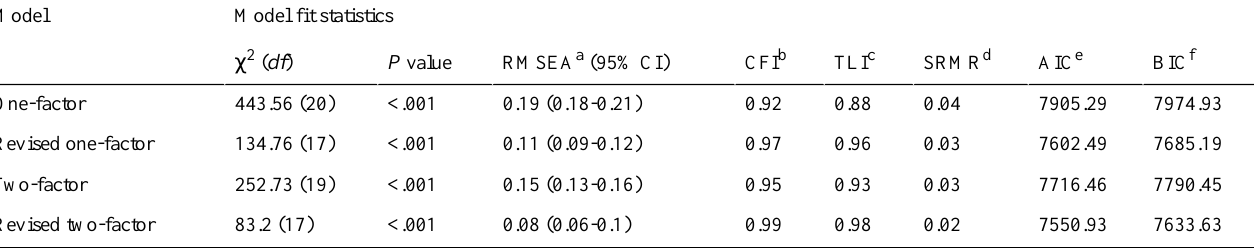
Table 2. Confirmatory factor analysis of the simplified Chinese eHealth literacy scale. Model fit